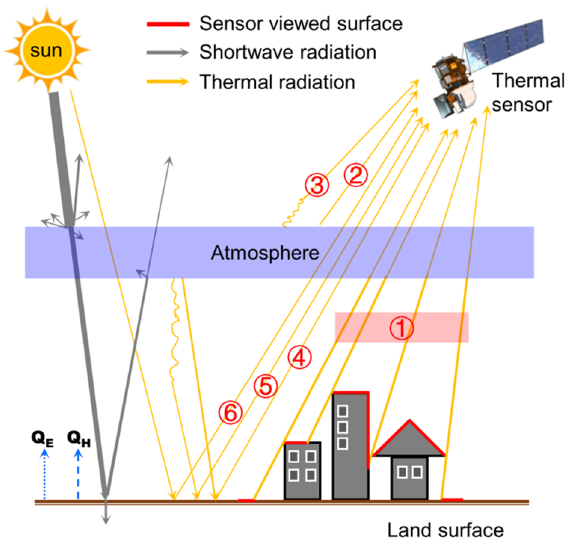
Figure 6. Illustration of the infrared radiance received by a satellite sensor. Path 1 (cid:13) : radiance emitted directly by the target surface. Path 2 (cid:13) : upward atmospheric thermal radiance. Path 3 (cid:13) : upward solar diffusion radiance scattered by the atmosphere. Paths 4 (cid:13) : downward atmospheric thermal radiance. Path 5 (cid:13) : downward solar diffusion radiance. Path 6 (cid:13) : direct solar radiance reflected by the surface. The radiance from paths 1 (cid:13) , 4 (cid:13) , 5 (cid:13) , and 6 (cid:13) will be attenuated by the atmosphere before reaching the sensor. Among these channels, only the radiance from path 1 (cid:13) is directly related to land surface temperature and the emissivity of interest. The solar-related items (paths 3 (cid:13) , 5 (cid:13) , and 6 (cid:13) ) are usually ignored in LST retrieval due to a negligible solar radiation infrared thermal window of 8 to 14 µ m